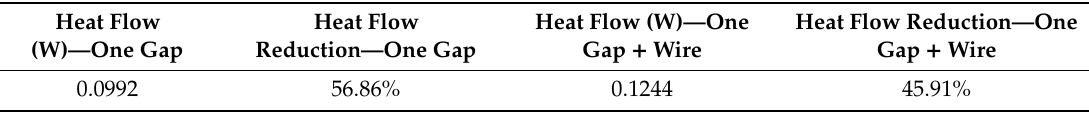
Table A1. Calculated heat flow and heat flow reduction compared to case of coaxial line with no gaps ( R ’ = 15 mm; acetal